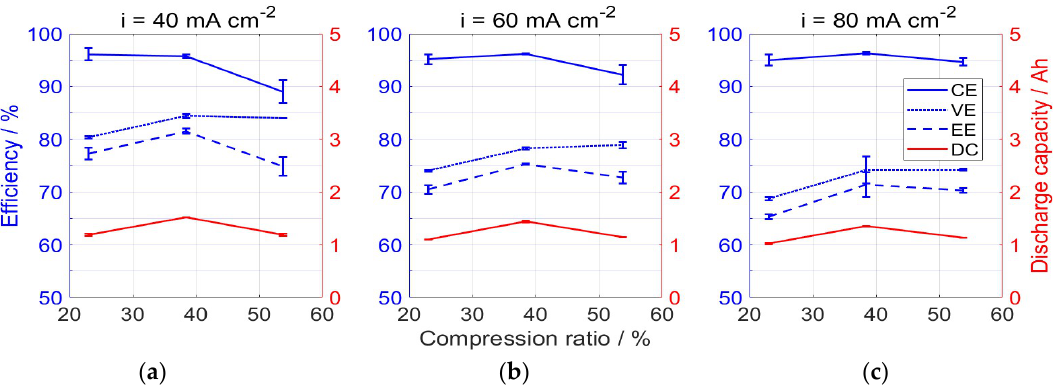
Figure 4. Effects of CR on the coulombic, voltage and energy efficiency and discharge capacity of the VRFB operating at 50 mL min −1 under various current density levels: ( a ) 40 mA cm −2 ; ( b ) 60 mA cm −2 ; ( c ) 80 mA cm −2 .